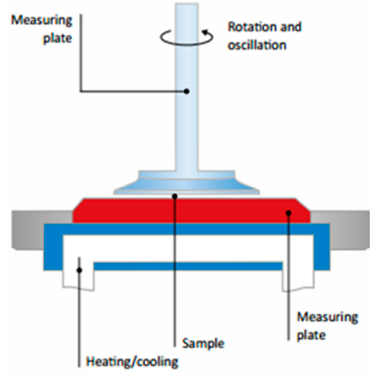
Figure 4. Parallel-plate measuring system in the rotational and oscillatory rheometer.